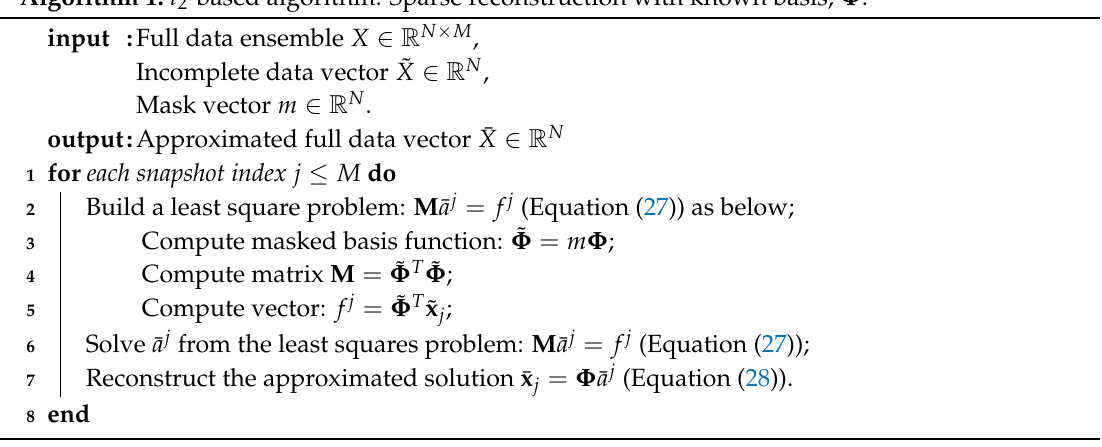
Algorithm 1: l 2 -based algorithm: Sparse reconstruction with known basis, Φ